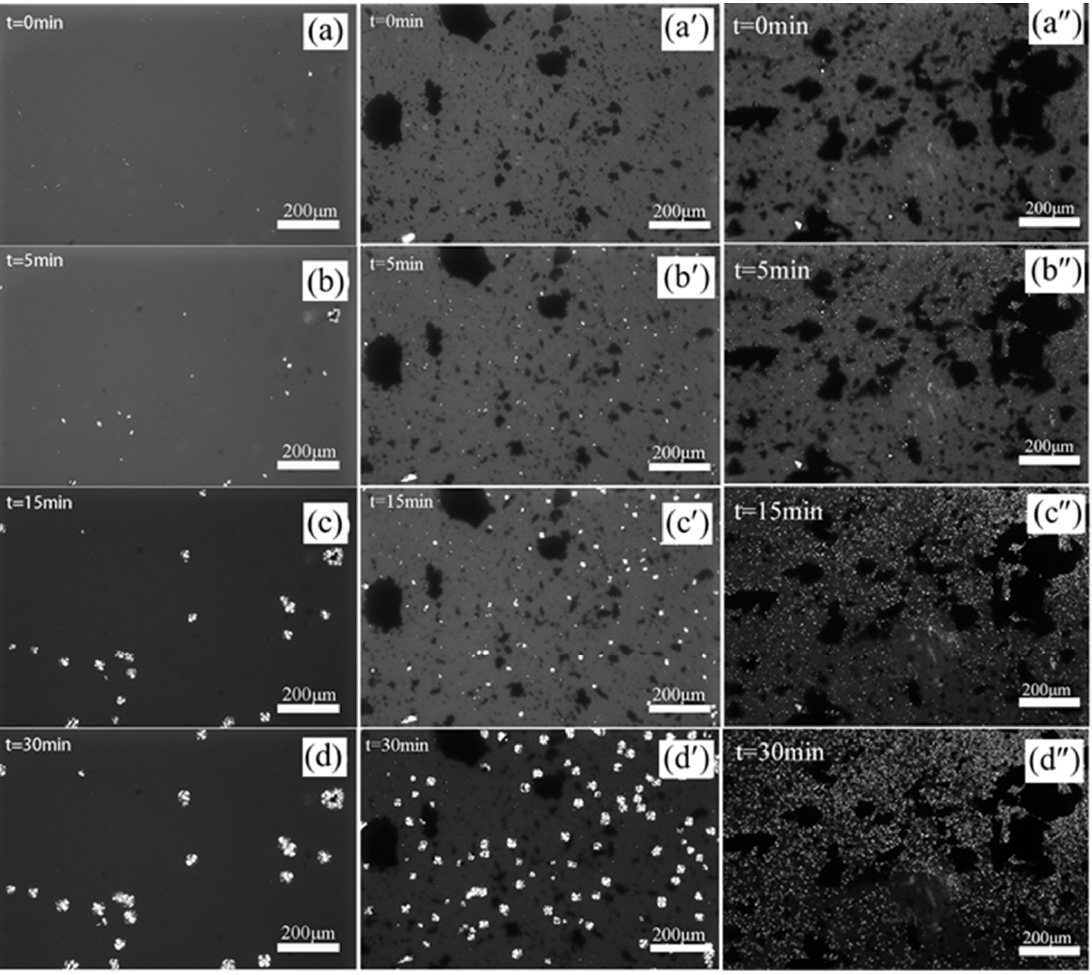
Figure 7. POM images of crystal growth at 130°C with different times: ( a–d ) PLA. ( a – d ) PLA/GTR5. ( a – d ) PLA/GTR5-D1.0. ( a” – d” )